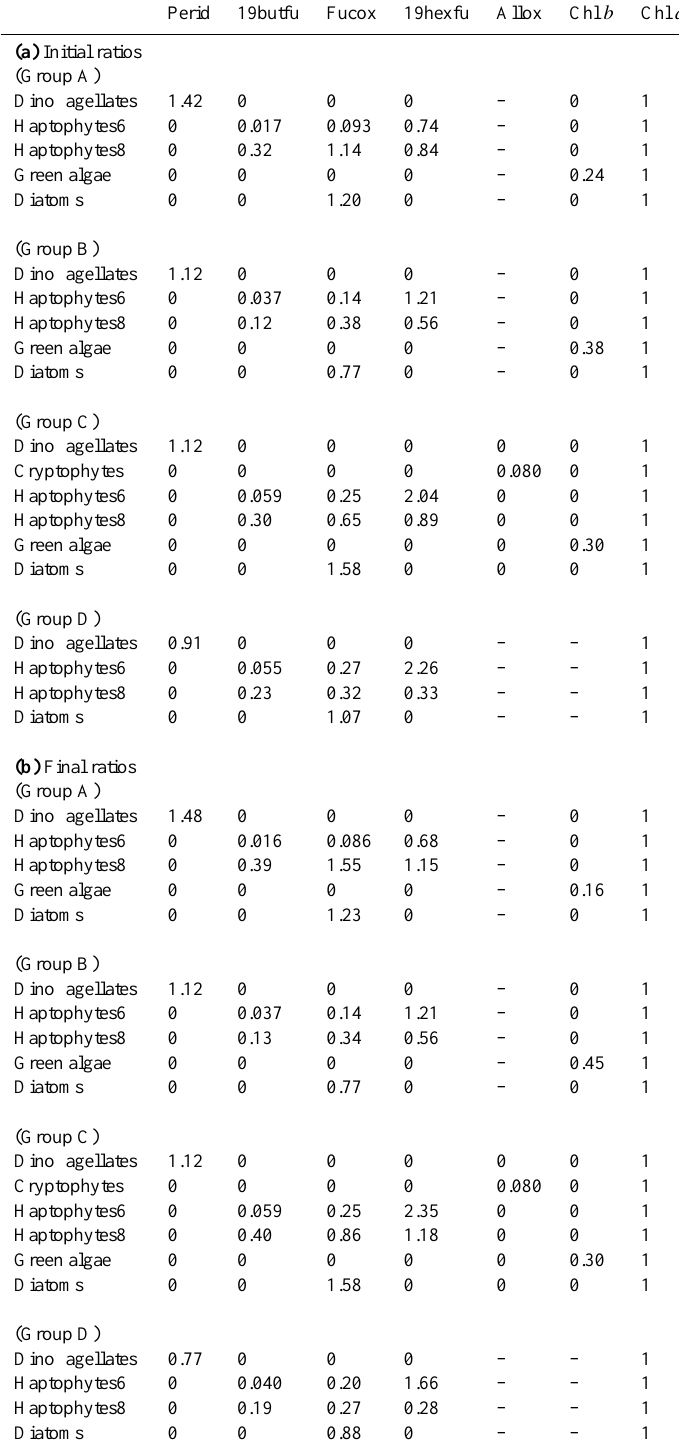
Table 1. CHEMTAX analysis of accessory pigment to chl a ratios in the major algal classes: (a) initial ratios; (b) final ratios. Perid, peridinin; 19butfu, 19 0 -butanoyloxyfucoxanthin; Fucox, fucoxanthin; 19hexfu, 19 0 -hexanoyloxyfucoxanthin; Allox, alloxanthin; Chl b , chlorophyll b ; Chl a , chlorophyll a . Groups A–D represent categories based on the cluster analysis using pigment data. Note: The common name “Green algae” includes Chlorophyceae and Prasinophyceae and possibly